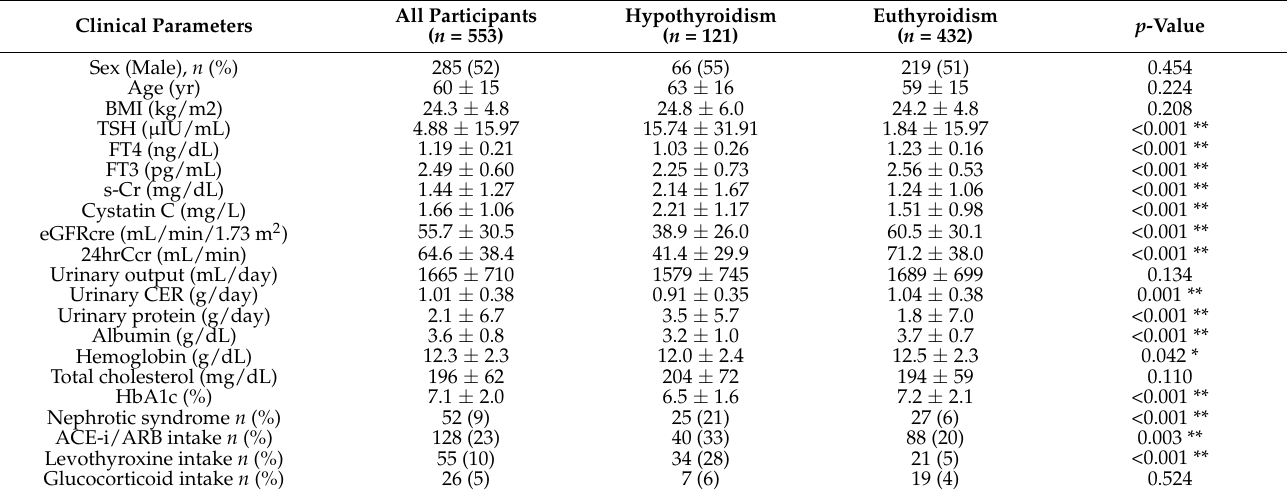
Table 2. Characteristics of study participants stratified by thyroidal